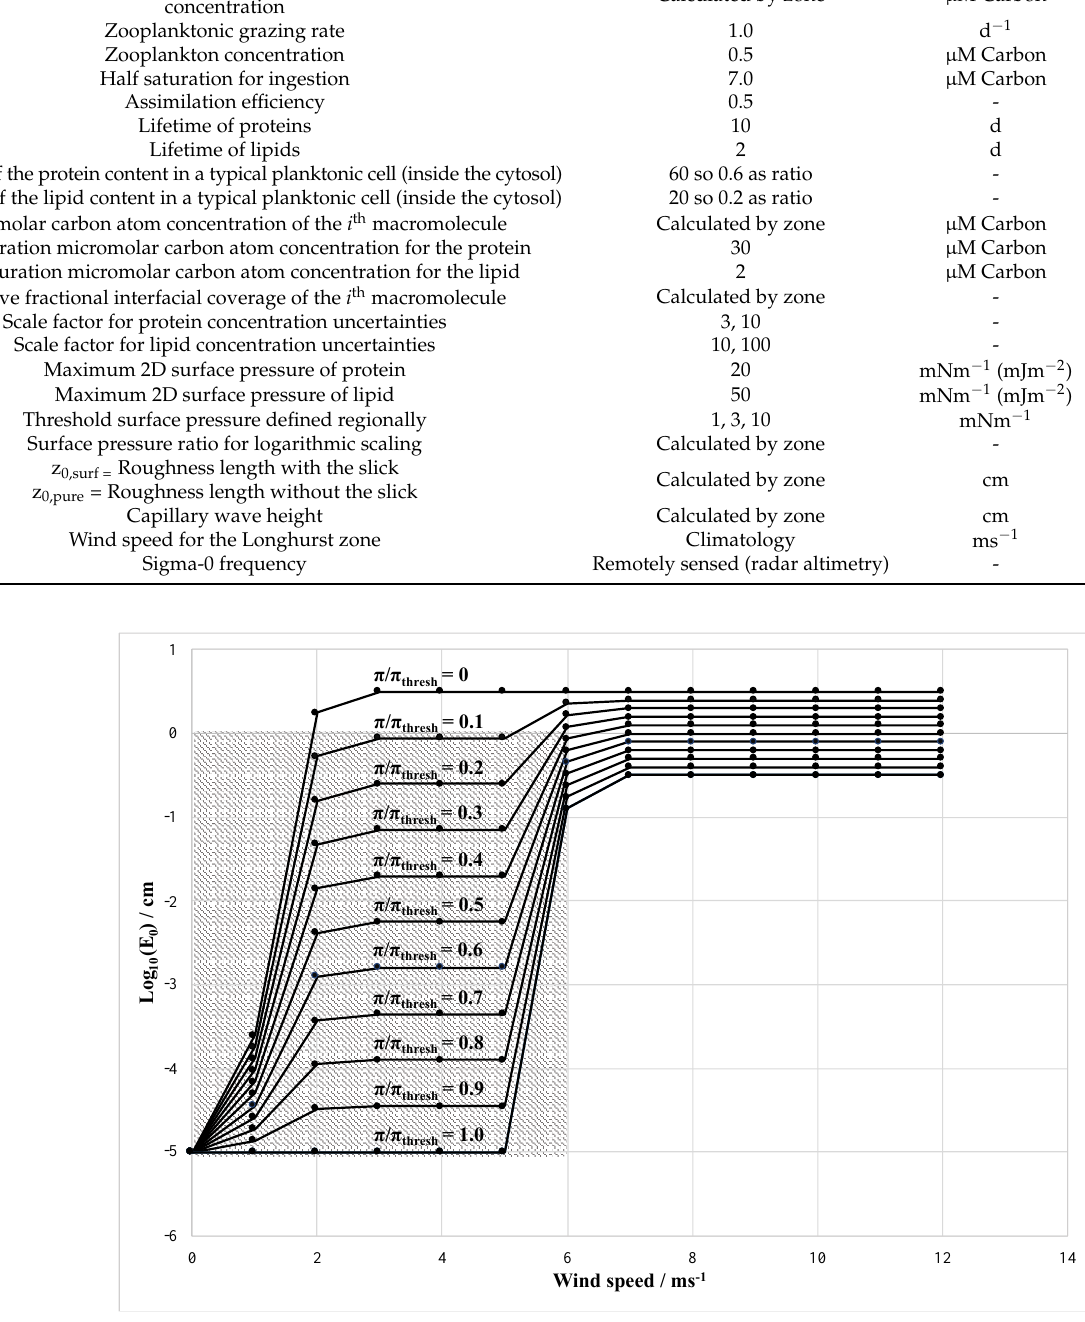
Figure 1. Elemental height (cm) as a function of 10 m wind speed and varying surface pressure ratios. Shaded area indicates parameter space where E 0 < 1 cm.